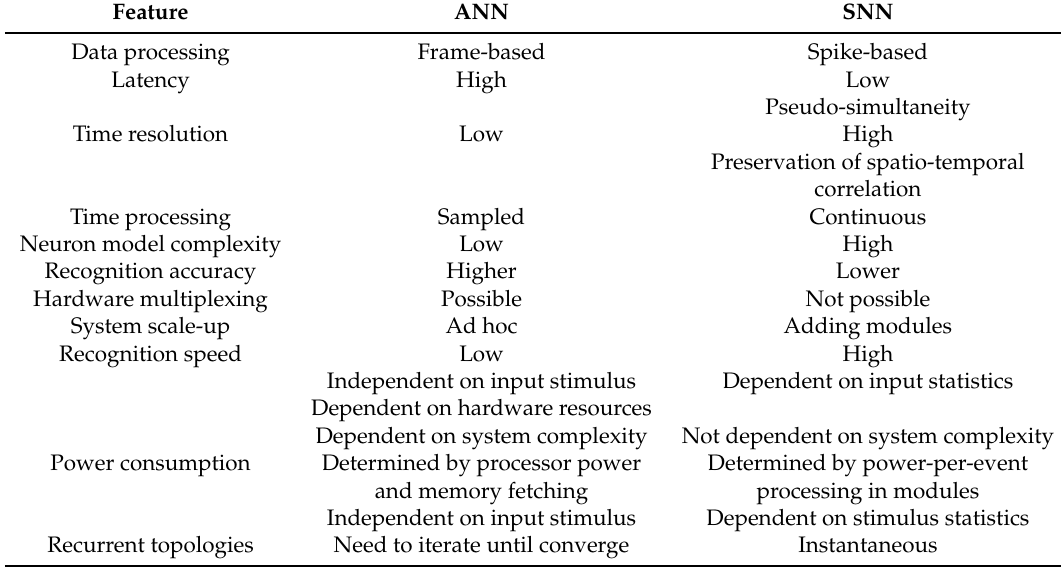
Table 1. Table comparing different features of ANNs and